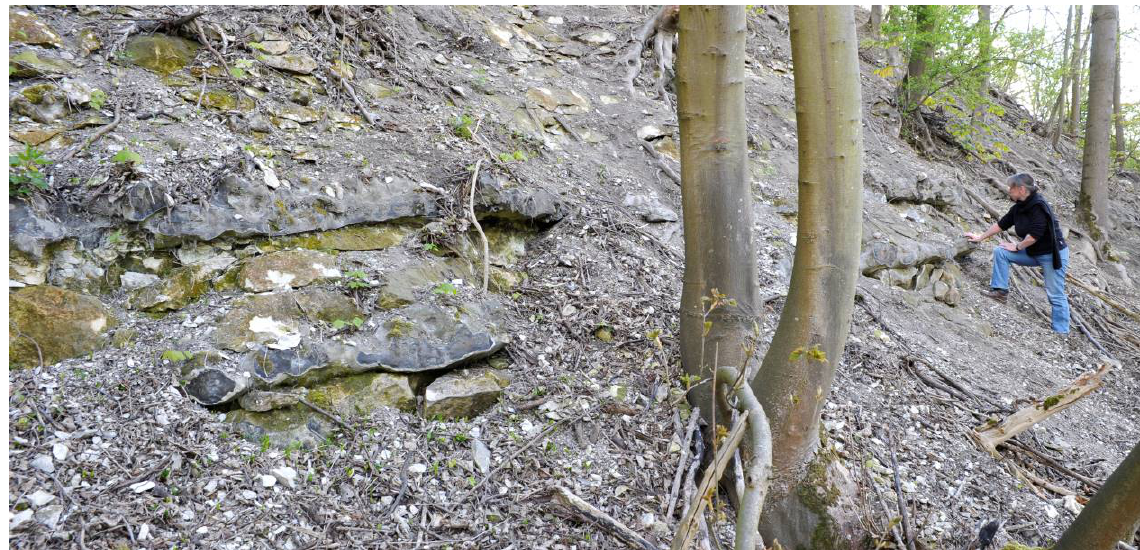
Figure 9. Spiennes. Twin tabular flint seams in the railway embankment in Camp-à-Cayaux. Photo by M. Woodbury, SPW.